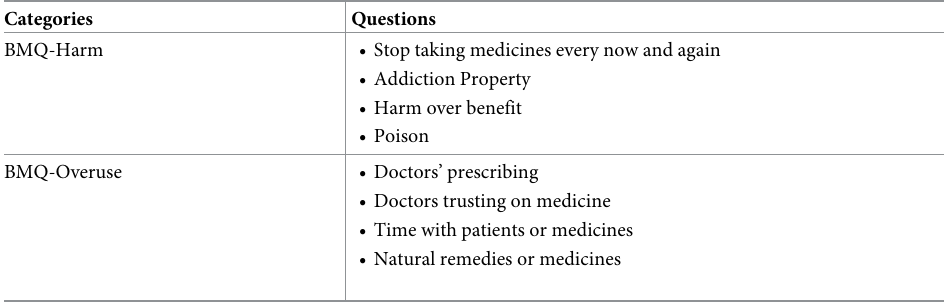
Table 1. Contents of beliefs about medicines questionnaire.